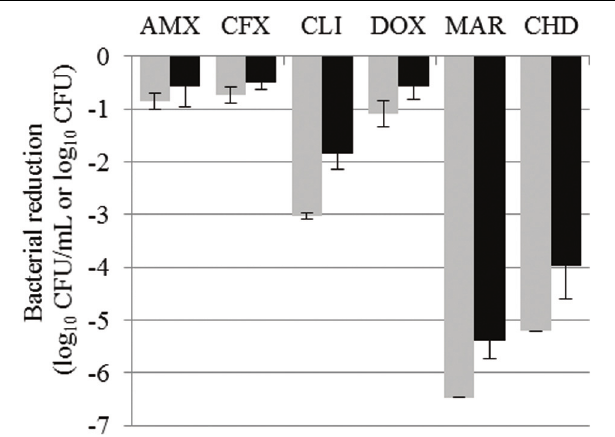
FIGURE 1 | Bacterial reductions (mean ± SD) of Staphylococcus aureus suspension (gray bars, in log 10 CFU/mL) and biofilm (black bars, in log 10 CFU) after 15-h exposure to amoxicillin (AMX), cefalexin (CFX), clindamycin (CLI), doxycycline (DOX), or marbofloxacin (MAR) or after 5- min exposure to chlorhexidine (CHD).